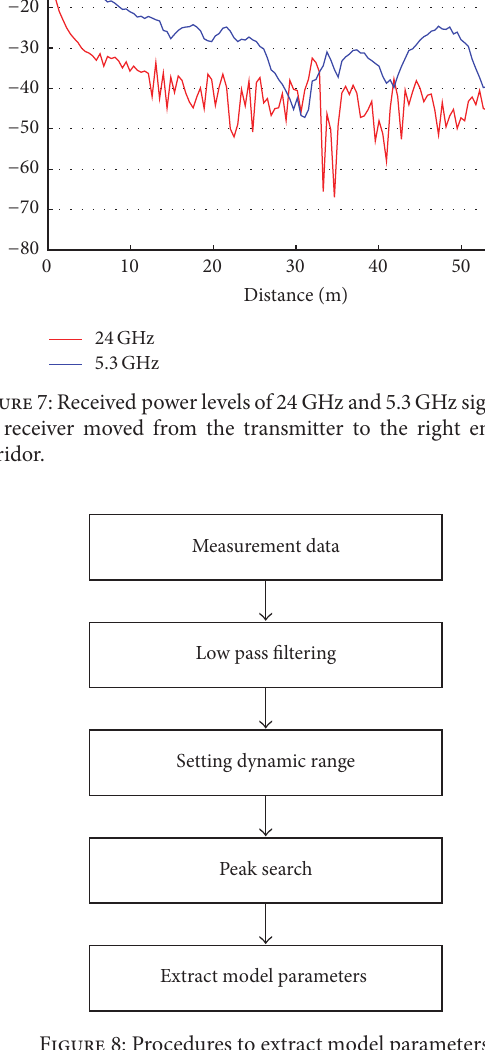
Table 1: Coordinates of the transmitter, the receiver, and corners of the test site. Metric unit is used.